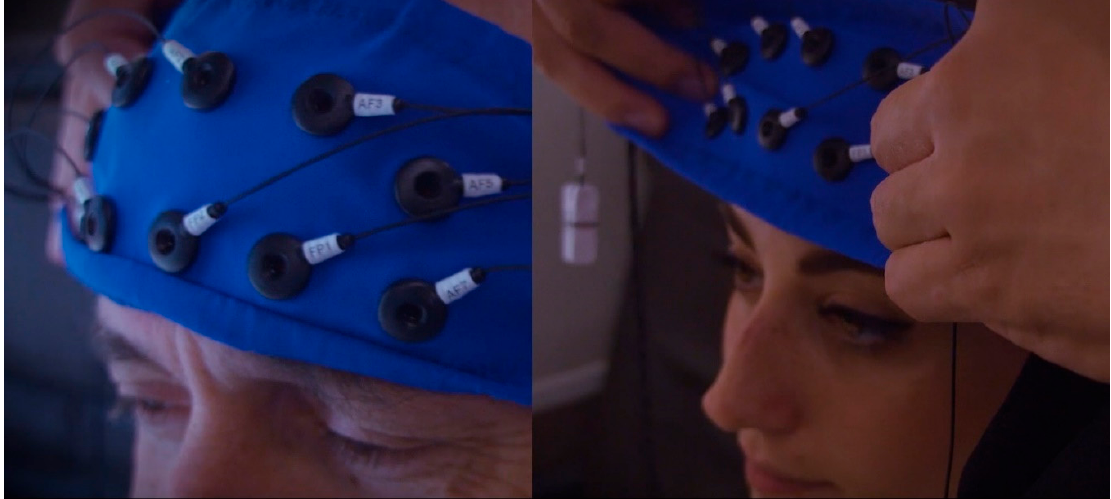
Figure 6. EEG frontal headband with ten electrodes (Fpz, Fp1, Fp2, AFz, AF3, AF4, AF5, AF6, AF7, and AF8).